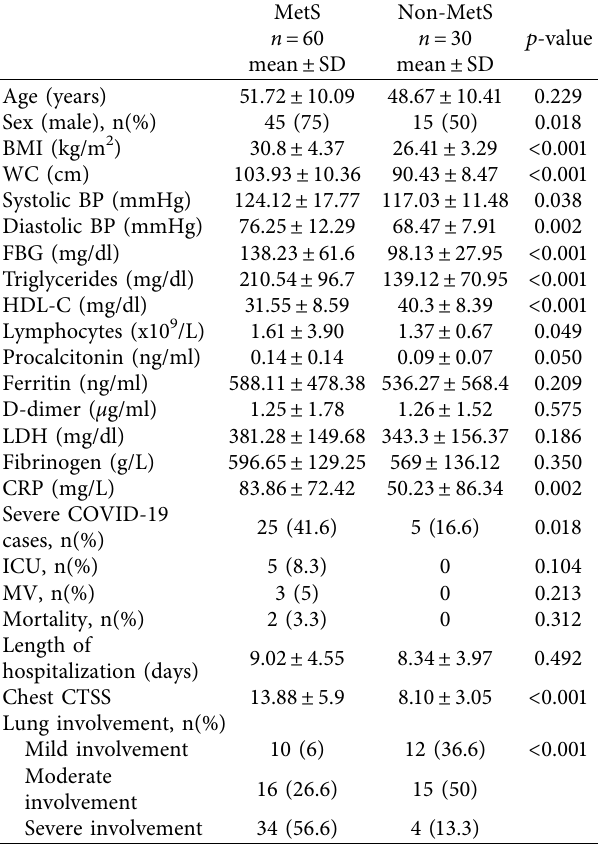
Table 2: Clinical, laboratory, and radiological characteristics of patients with COVID-19 disease according to the presence of metabolic syndrome.